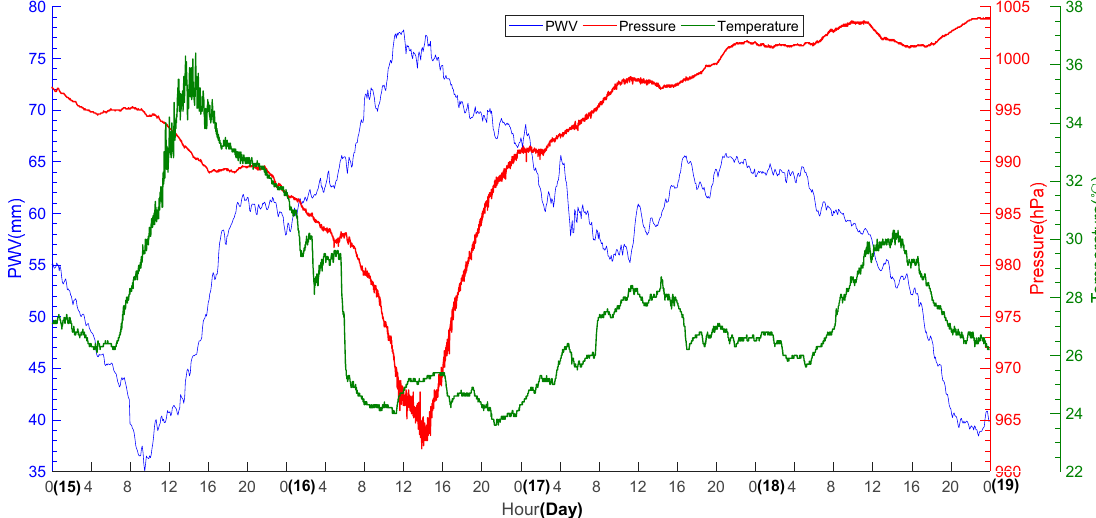
Figure 10. Time series of 3-min GNSS-PWV, 1-min temperature, and 1-min pressure over the HKSL station during stations the four-day period of 15–18 Sept.